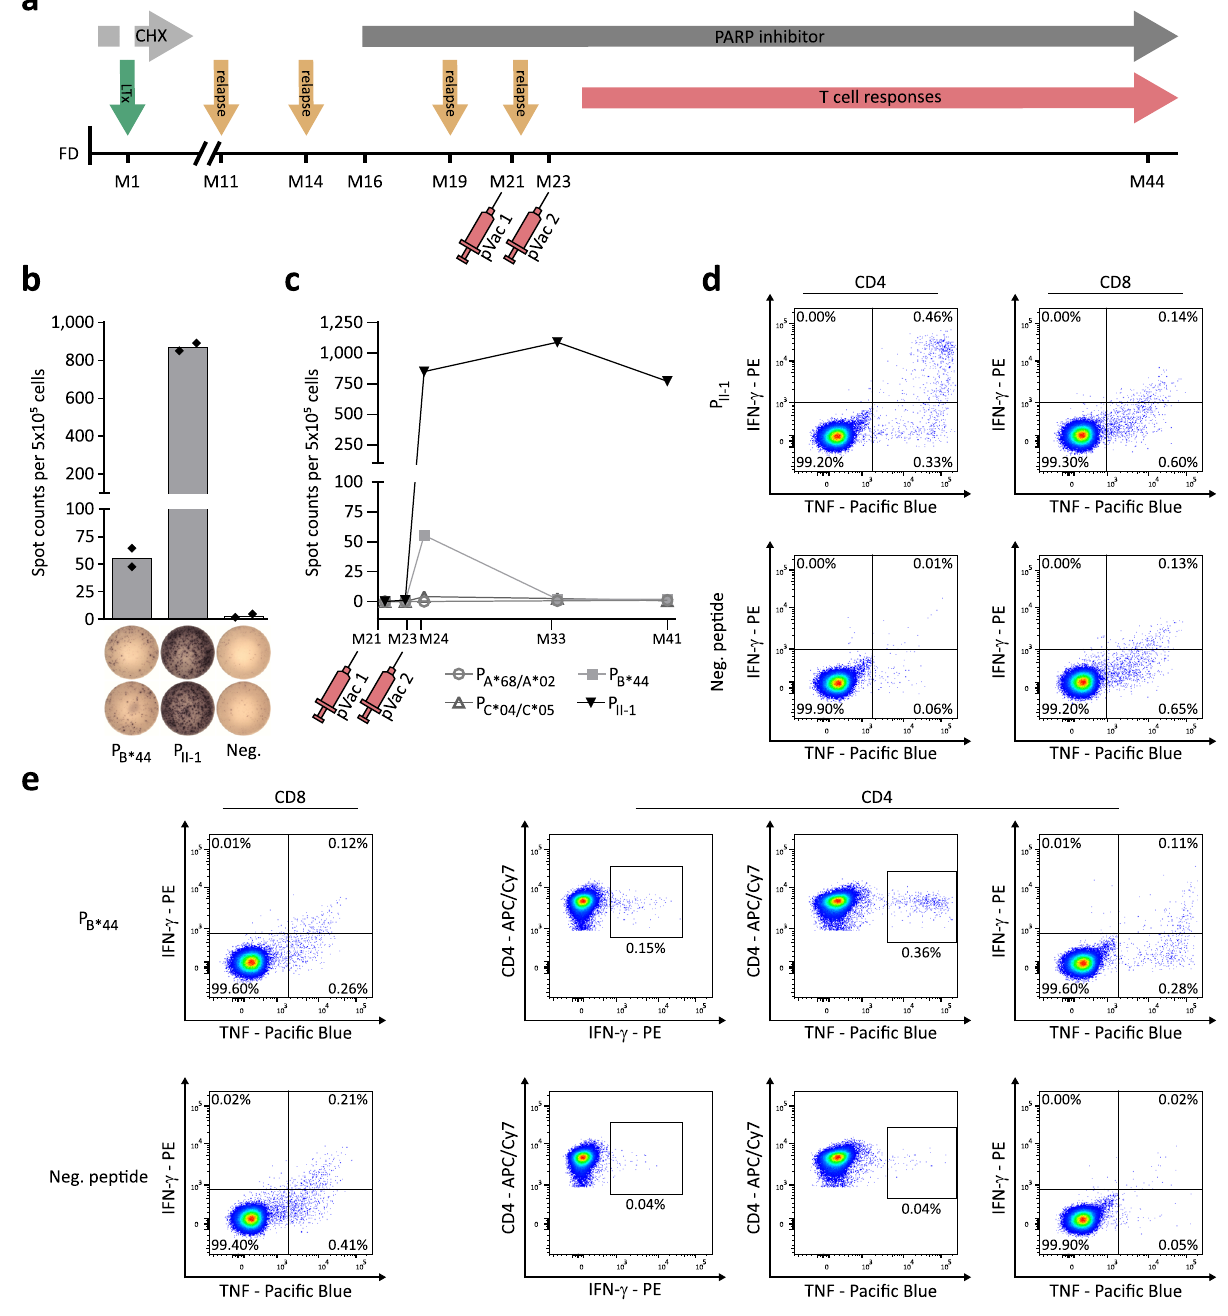
Fig. 4 | FL-HCC patient vaccinated with a personalized DNAJB1-PRKACA- derived peptide vaccine. a Schematic therapy course of a fi brolamellar hepato- cellular carcinoma (FL-HCC) patient treated with a DNAJB1-PRKACA-derived pep- tide vaccine cocktail. After fi rst diagnosis (FD) the patient was treated with four cycles of chemotherapy (CHX) analogous to the PHITT study (PHITT Group F) interruptedbyanearlylivertransplant(LTx)onemonth(M1)afterFD,asthetumor was assessed not resectable. Everolimus was used for post-transplantation immu- nosuppression.ThepatientexperiencedfourrelapsesafterLTxatmonths11,15,19, and 21post-FD. Tumor manifestations ofthe fi rst, second,and fourth relapse were surgically resected, and for the third relapse, radiotherapy was applied. Starting at month 16 post-FD the patient was treated with Olaparib (poly (ADP-ribose) poly- merase (PARP) inhibitor). At months 21 and 23, the patient received two vaccina- tions of a personalized DNAJB1-PRKACA-derived peptide vaccine comprising the